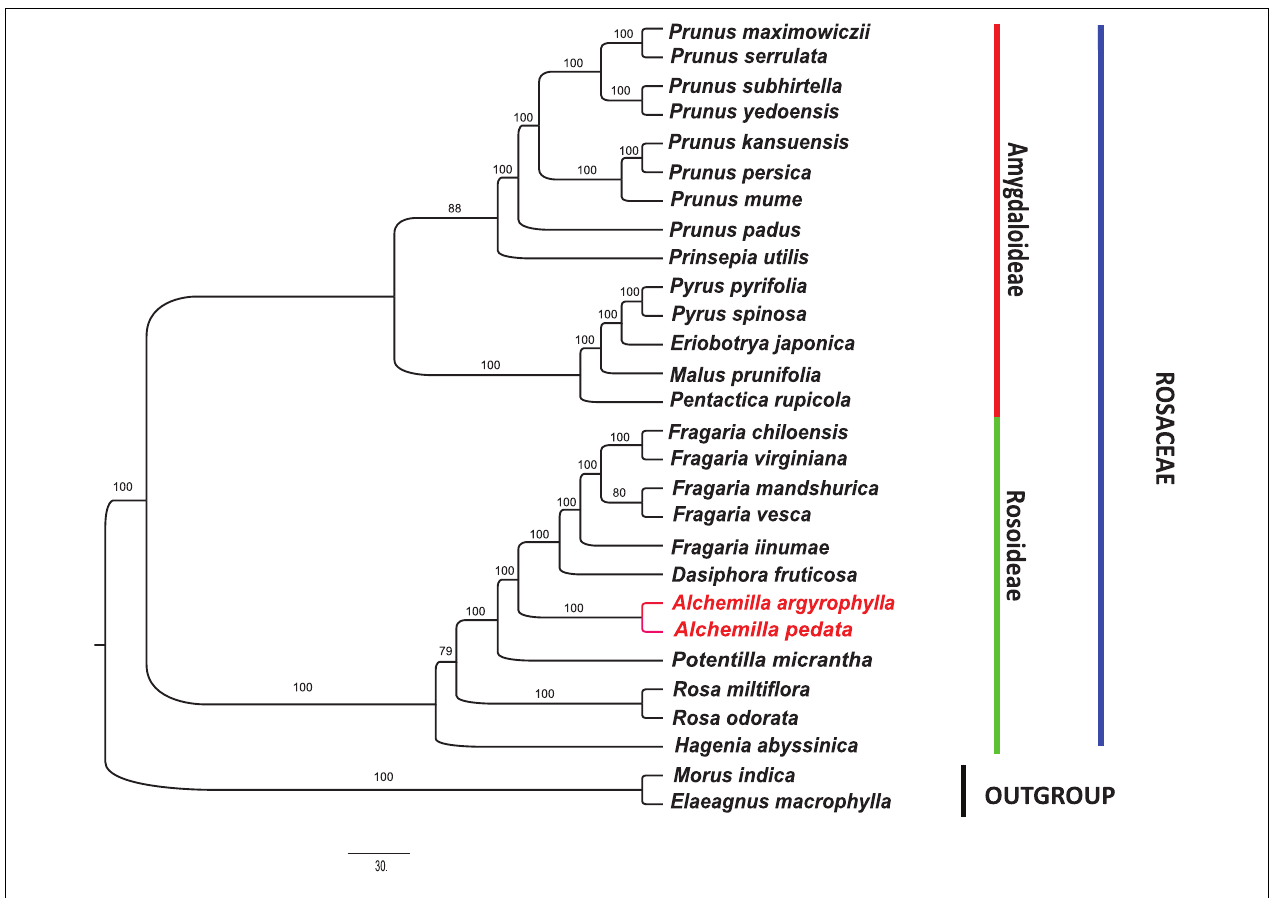
FIGURE 5 | Phylogenetic tree reconstruction of Rosaceae species based on maximum-likelihood (ML) analysis using the program IQ-Tree v.6.1 (Nguyen et al., 2015) with 1,000 bootstrap replications in 26 complete chloroplast genome sequences. Morus indica and Elaeagnus macrophylla were used as